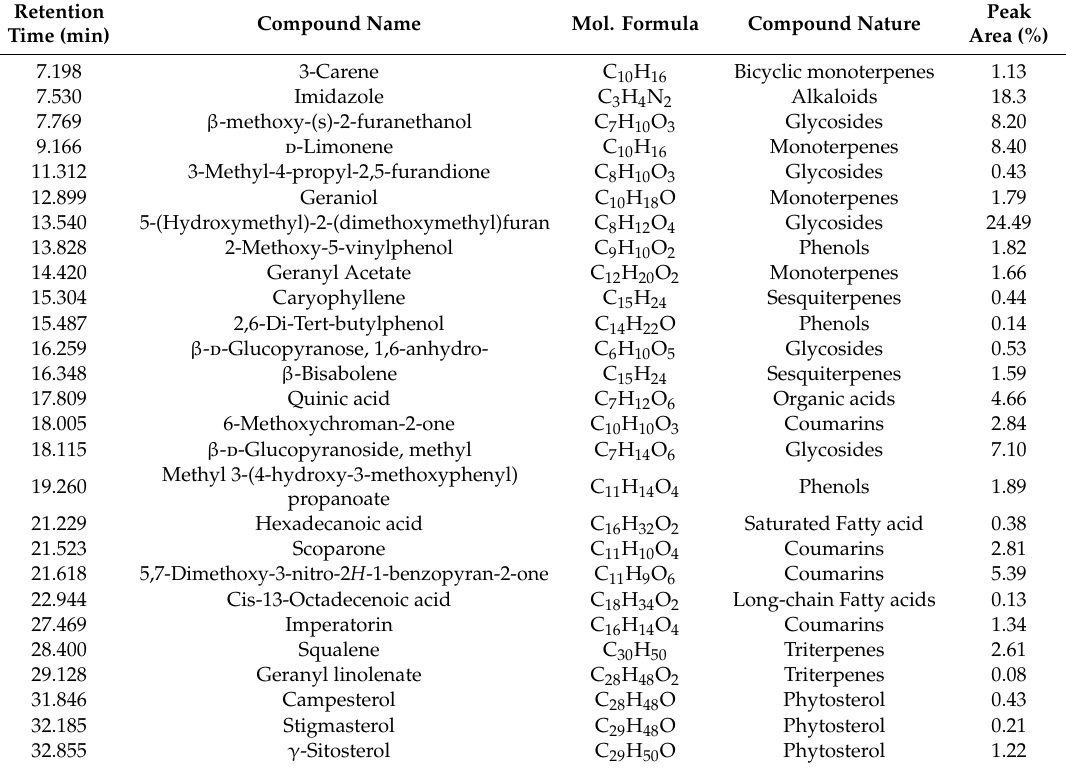
Table 2. Phytochemical active constituents of dried lemon methanolic extract.